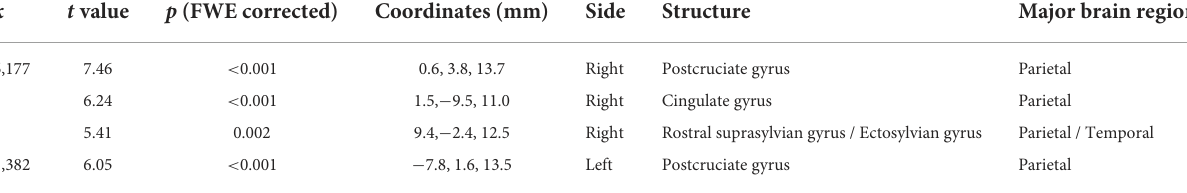
TABLE 1 Details of the clusters that showed a significant decrease with aging in gray matter.